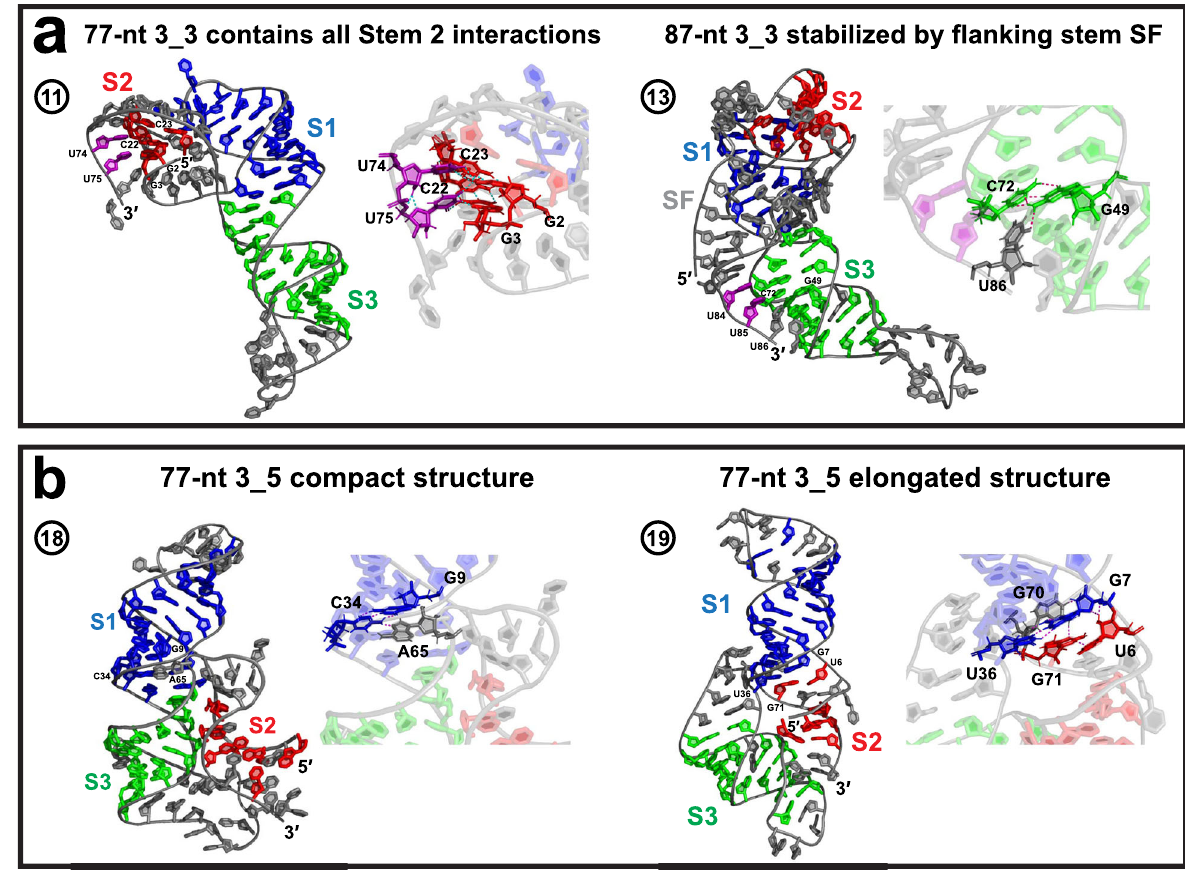
Fig. 5 Alternative 3_3 and 3_5 motifs. a The 77 and 87-nt 3_3 pseudoknot structures (model 11 and 13 in Table 1). For 77-nt, two residues in the 3 0 end (purple), which are involved in the 3_6 and 3_5 Stem 2, form triplets with the 3_3 Stem 2. For 87-nt, the 5 0 and 3 0 ends base pair to form fl anking stem SF, and the same two 3 0 end residues (purple) are locked around Stem 3 by a downstream triplet. b The 77-nt 3_5 junction compact and elongated structures (model 18 and 19). The Stem 2 helix formed by the 5 0 and 3 0 ends is stabilized around Stem 3 by multiple hydrogen